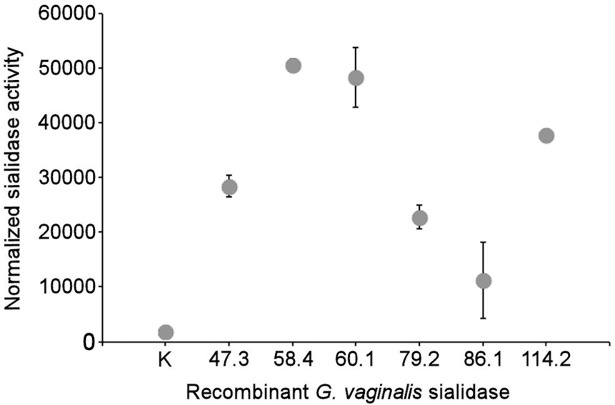
Activity of recombinant G. vaginalis sialidases in E. coli culture supernatants.The full-length sld gene from G. vaginalis isolates 47.3, 58.4, 60.1, 79.2, 86.1, and 114.2 was expressed in E. coli, and sialidase activity was assessed in the soluble fraction of the cell lysate. Sialidase activity was normalized to the total protein in the sample. K, soluble fraction of non-transformed E. coli cells (negative control). Error bars represent SD.